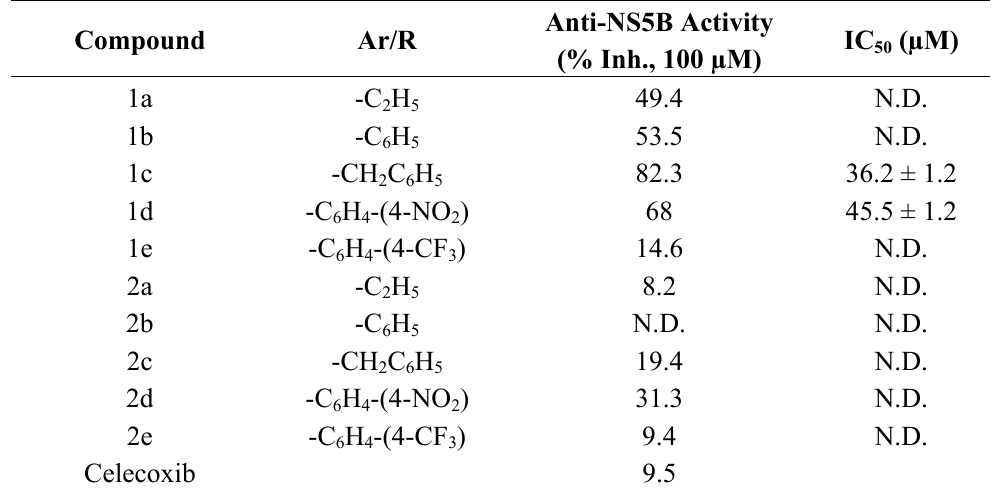
Table 7. Anti-HCV NS5B RdRp activity of celecoxib derivatives in vitro *